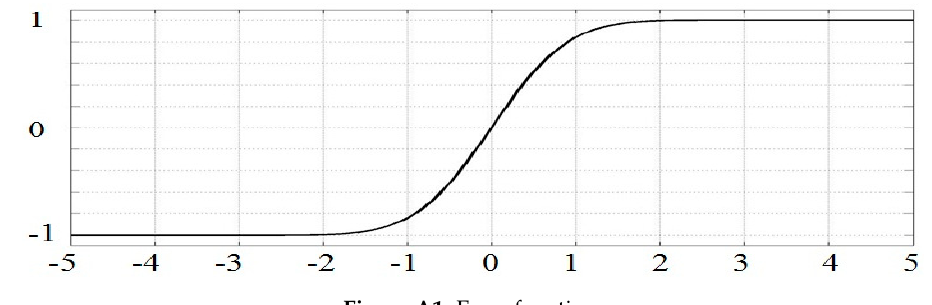
Figure A1. Error Figure A1. Error function.